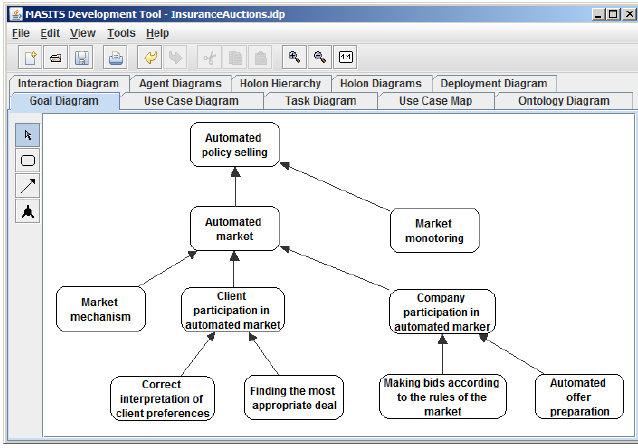
Fig 2. The MASITS tool with the goal